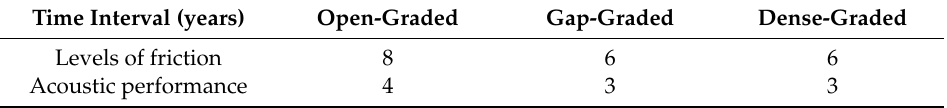
Table 4. Time interval between two consecutive maintenance interventions on the wearing